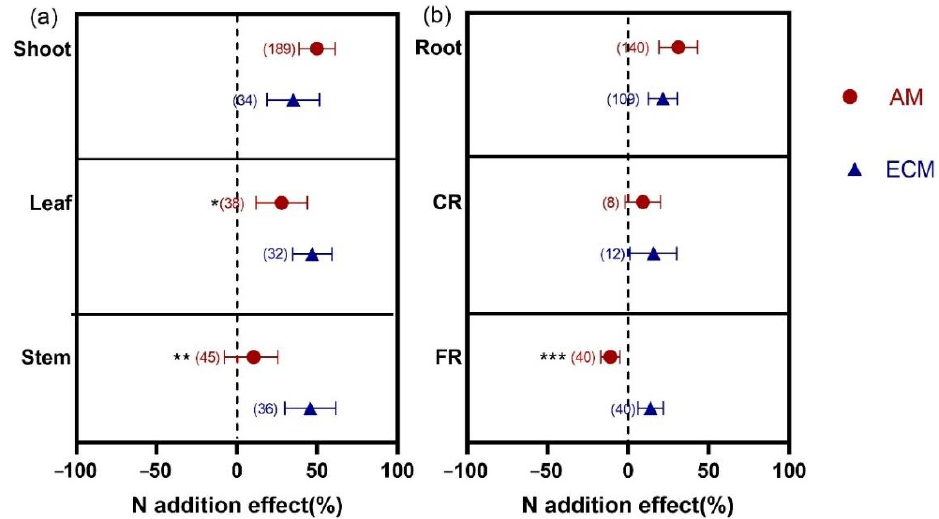
Figure 2. Effects of N addition on biomass of shoot, leaf, and stem ( a ) and biomass of root, CR, and FR ( b ) of AM and ECM plants. AM means arbuscular mycorrhizal type with typical AM structures. ECM means ectomycorrhiza type with typical ECM structures. The symbols represent the average of the 95% confidence intervals (CIs). The effect is considered to be significant when the 95% CI does not overlap with zero. The chi-square test was used to test the heterogeneity of all index effects between AM and ECM plants (*** p < 0.001, ** p < 0.01, and * p < 0.05). CR, coarse root; FR, fine root. The numbers in parentheses represent the sample size of observations.